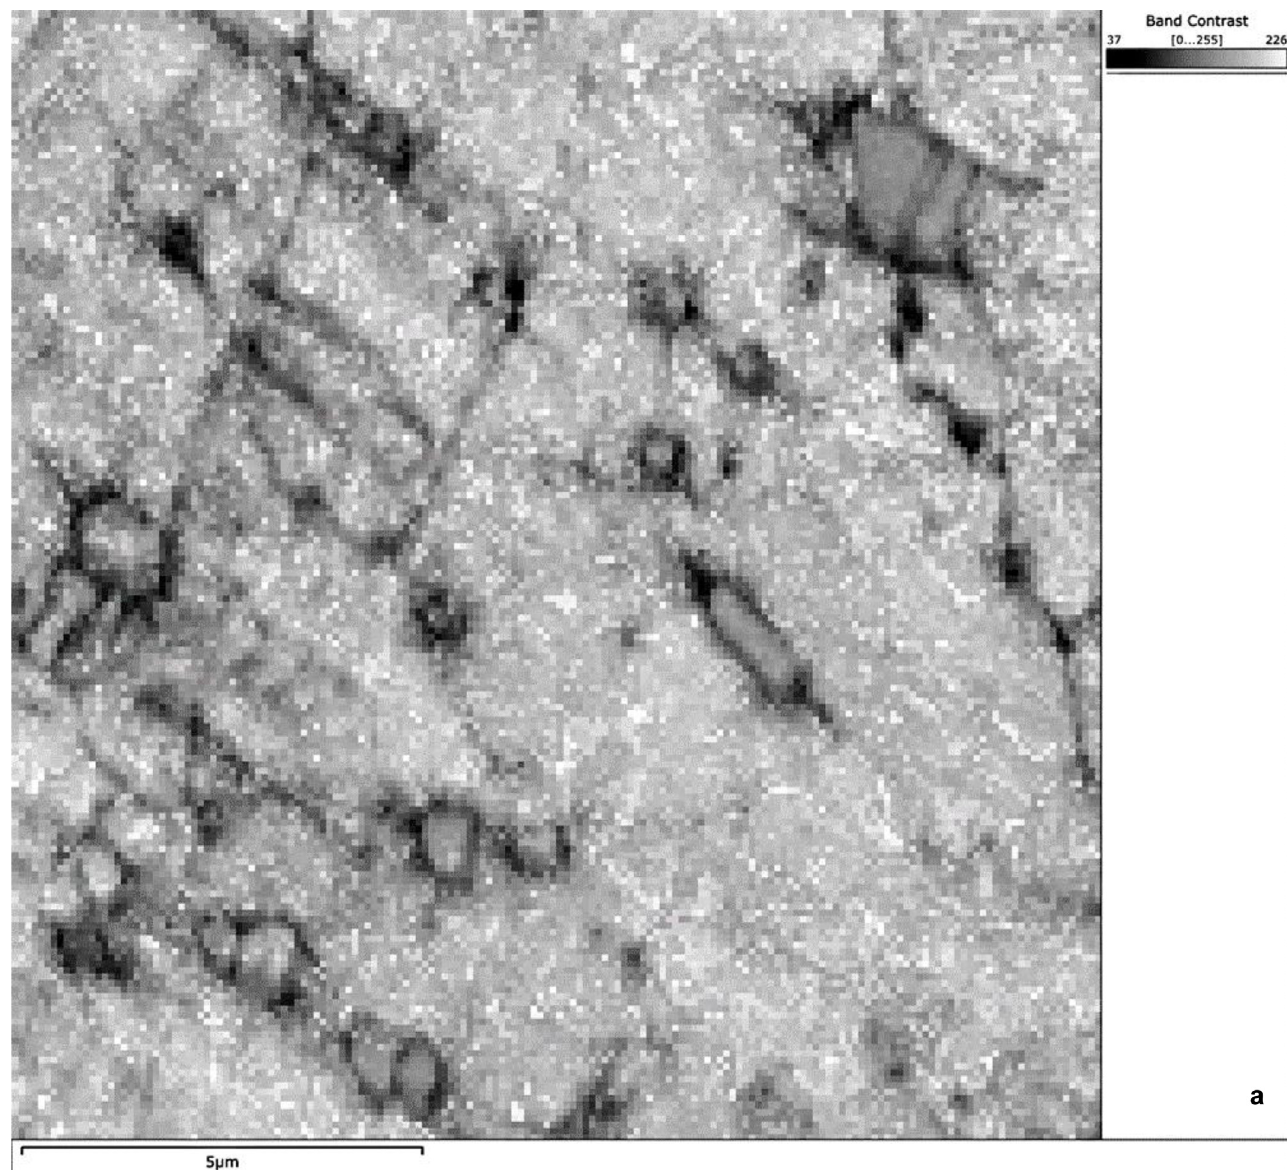
Fig. 15. HR EBSD map for the T6 temper. (a) Band contrast (cid:1) (b)